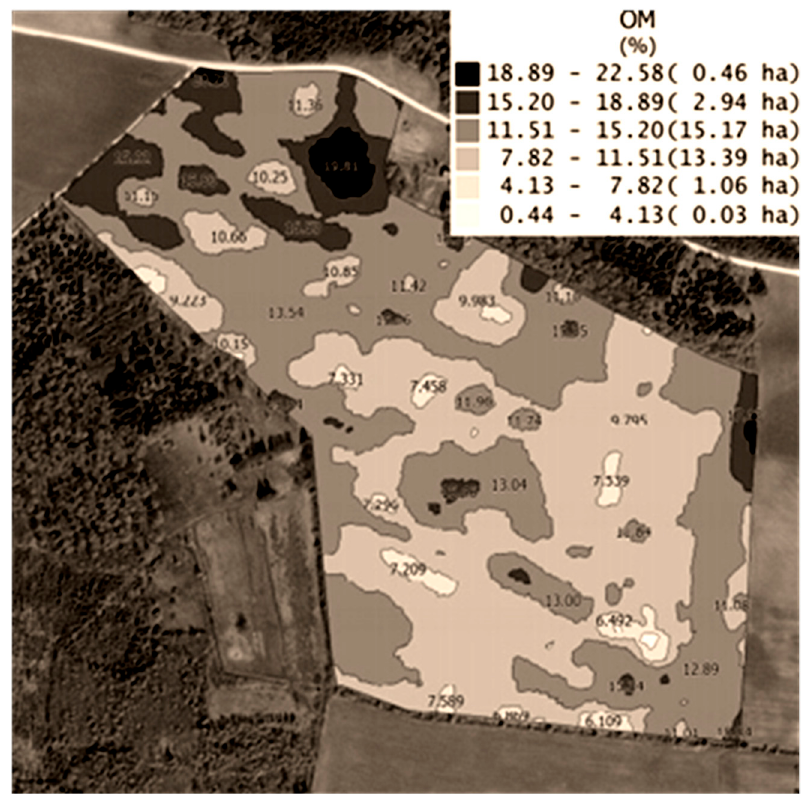
Figure 5. Map of soil organic matter differences. Colored parameter variation internal maps were created by the authors using a Veris MSP 3150; as a background layer, we used an ORT10LT digital raster orthophoto map of a territory in the Republic of Lithuania, M 1:10,000 (compiled 2012–2013) in the precision farming software AgLeader SMS Advanced.